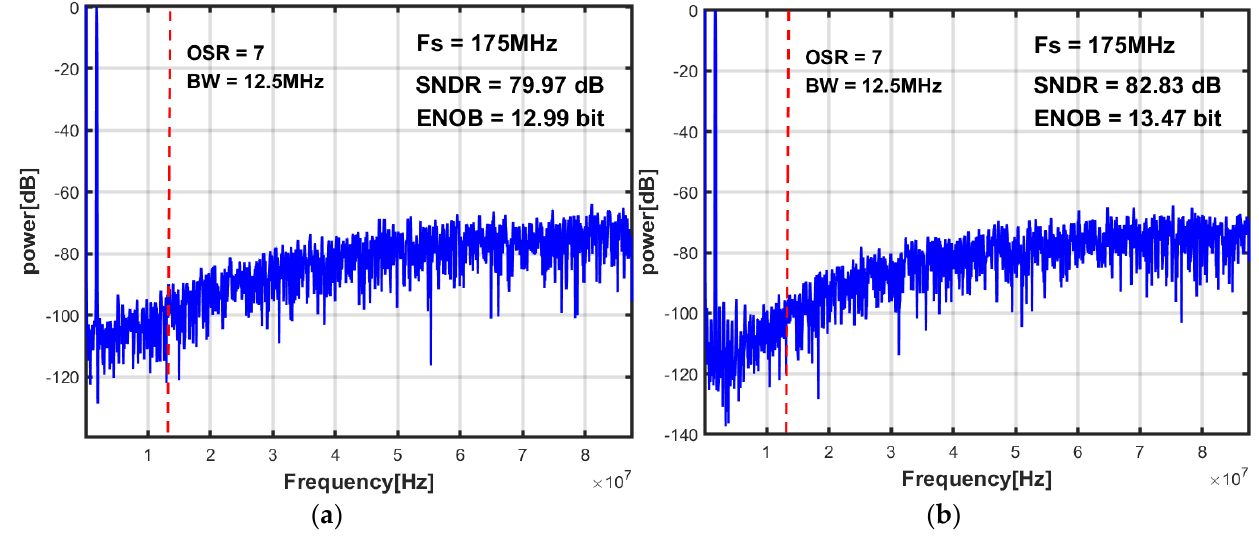
Figure 12. Simulated output power spectral density: ( a ) noise included; ( b ) RC-extraction included.